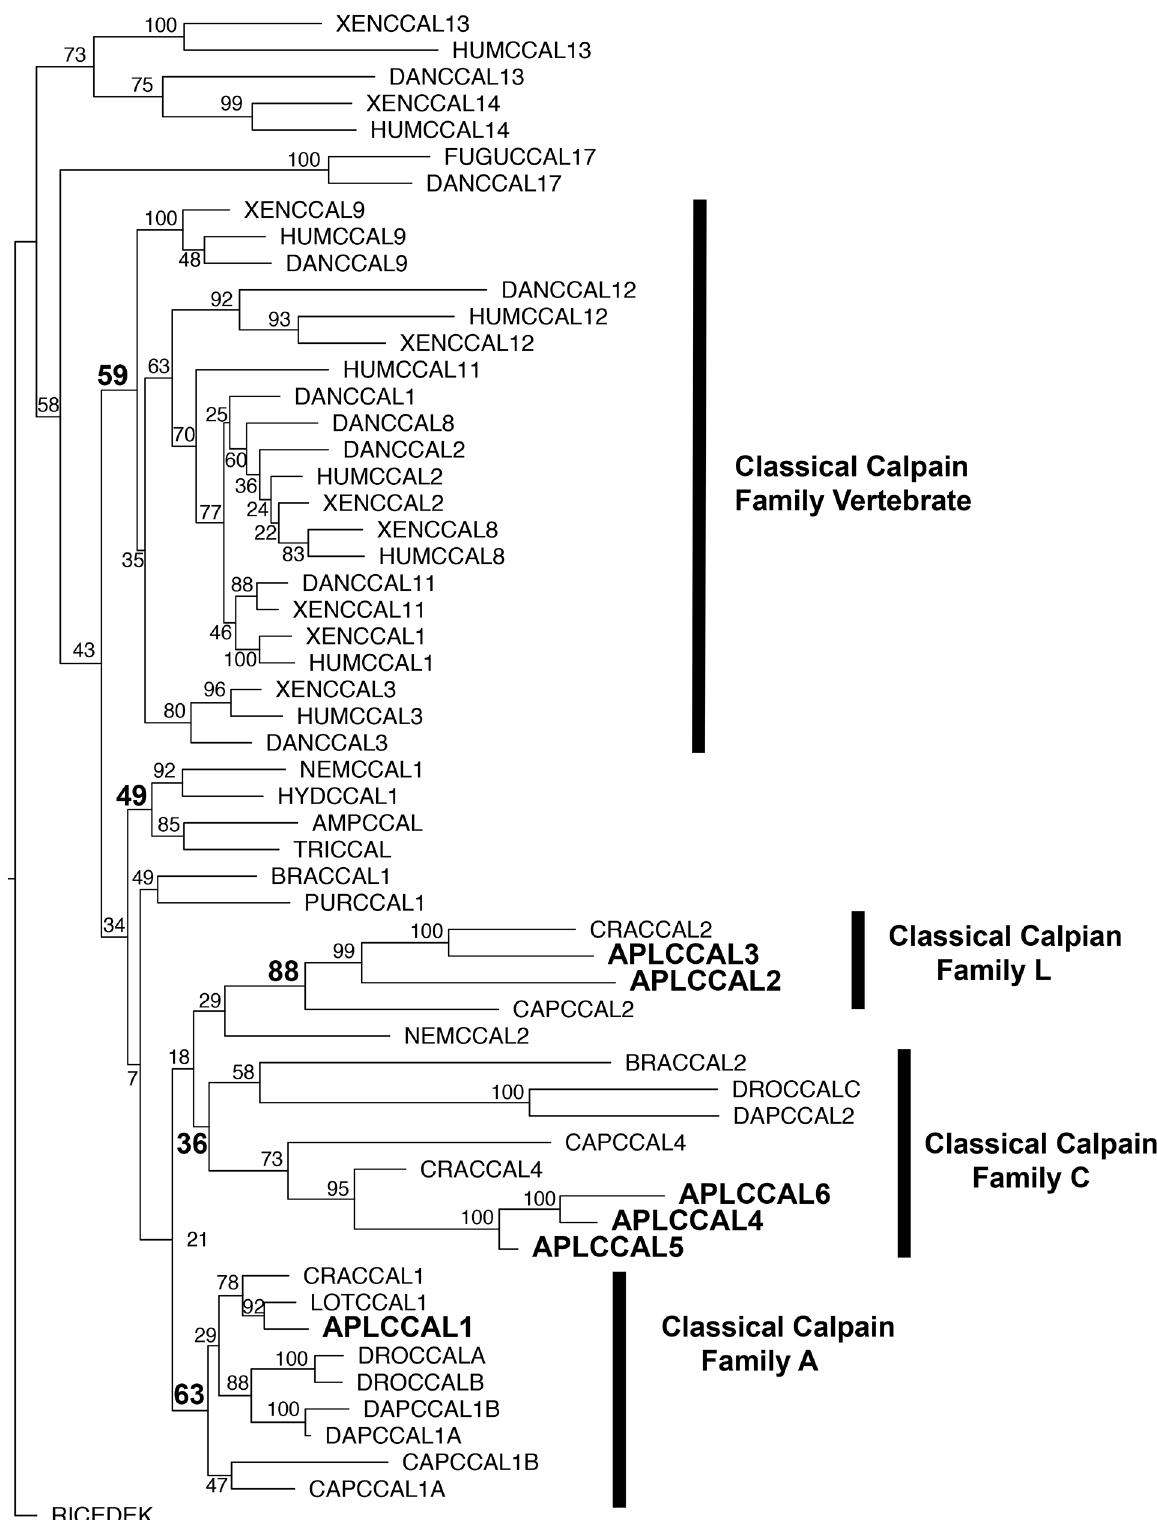
Fig 4. Phylogeny of classical calpain families. Speciesabbreviationsand their phylogenetic classificationand common name are detailedin Table 1. All reference numbers for sequencesare in S1 Table. The analysisis describedin the methods (the plot is from the